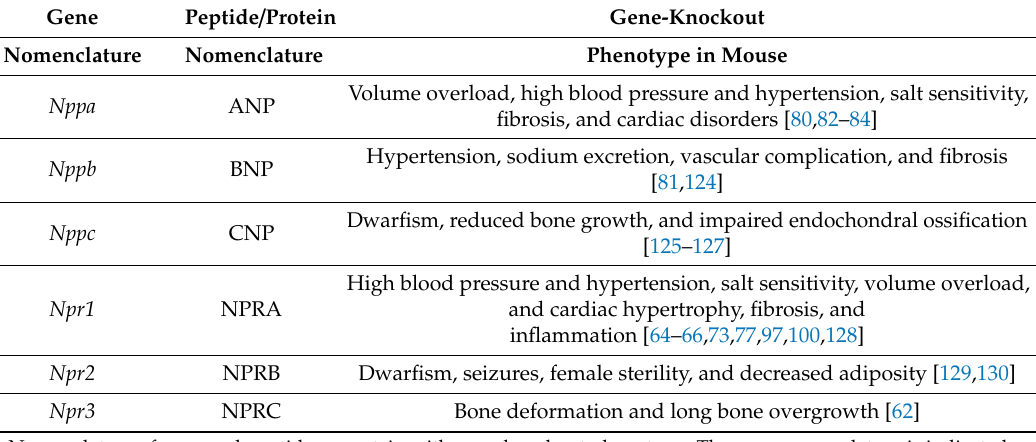
Table 1. The gene-knockout disease-specific phenotypes of mice with gene-disruption of natriuretic peptides and their cognate